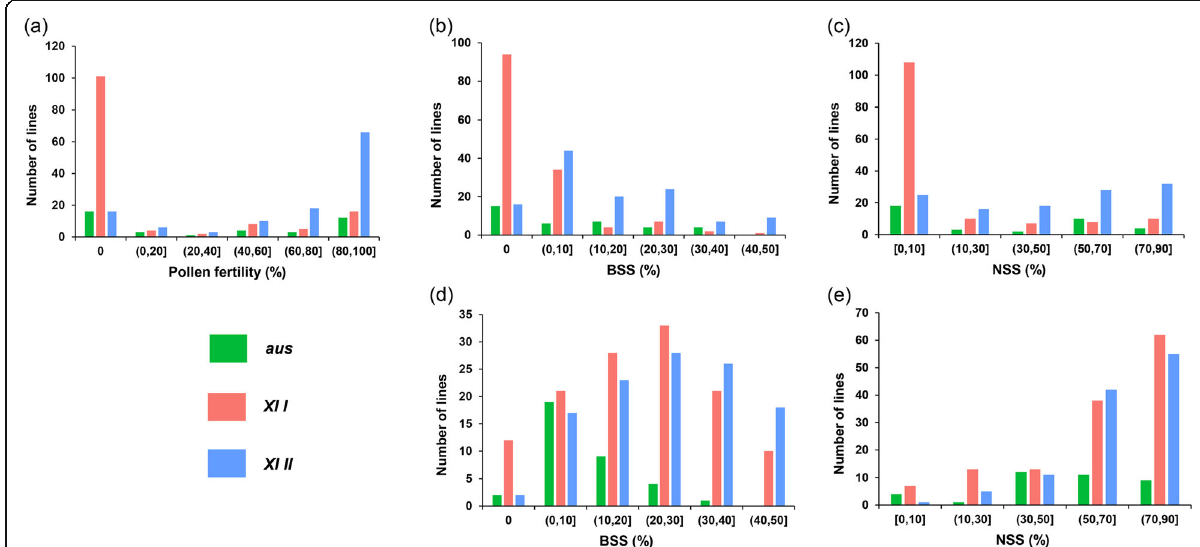
Fig. 2 Distribution of pollen fertility ( a ), BSS ( b ) and NSS ( c ) of the F 1 population with the background of CMS-WA, and BSS ( d ) and NSS ( e ) of the